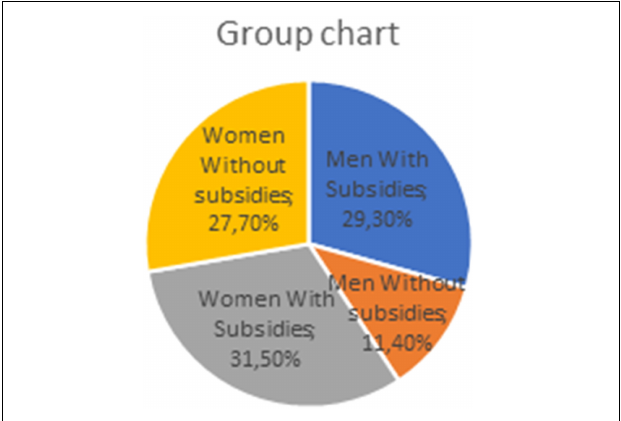
FIGURE 1 | Own elaboration/Wave 5 CRAM